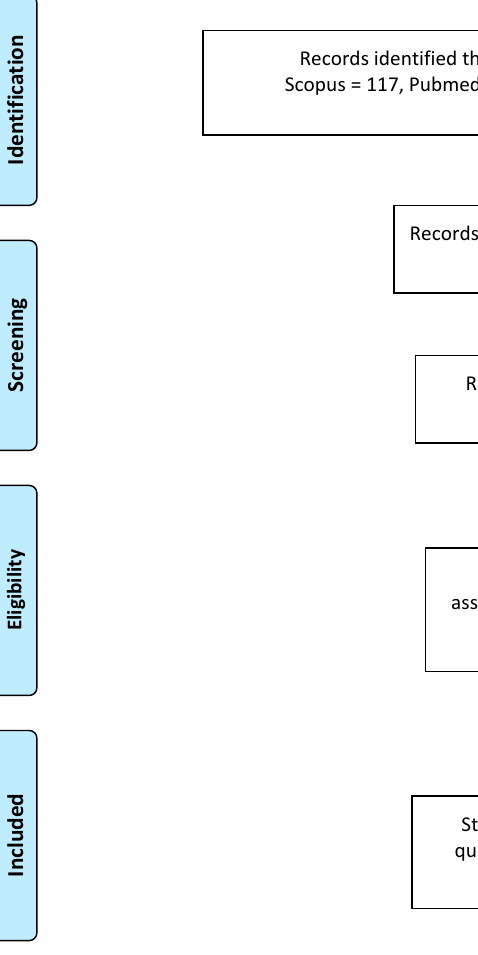
Figure 1. Preferred reporting items for systematic reviews (PRISMA) flow